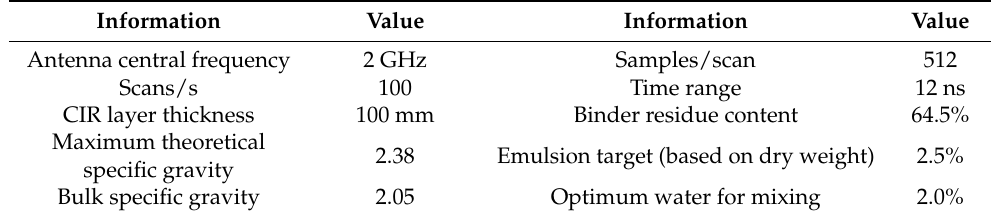
Table 1. Summary of test information.